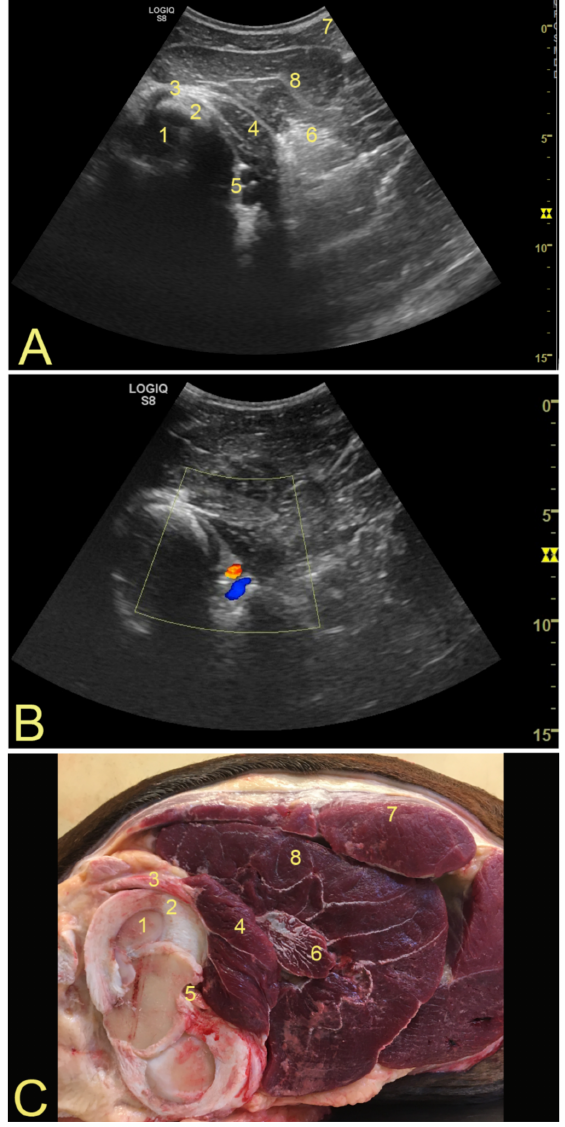
Figure 1. ( A ) Ultrasound aspect of the popliteal muscle. ( B ) Normal aspect and anatomy of the popliteal muscle and surrounding structures. To confirm the correct position of the probe, a doppler mode was used to demarcate the popliteal artery and vein. ( C ) An anatomical specimen is shown for orientation. Annotations: 1—caudo-lateral part of the lateral femoral condyle; 2—lateral menis- cus; 3—PopT; 4—PopM; 5—popliteal artery and vein; 6—fibrous superficial digital flexor